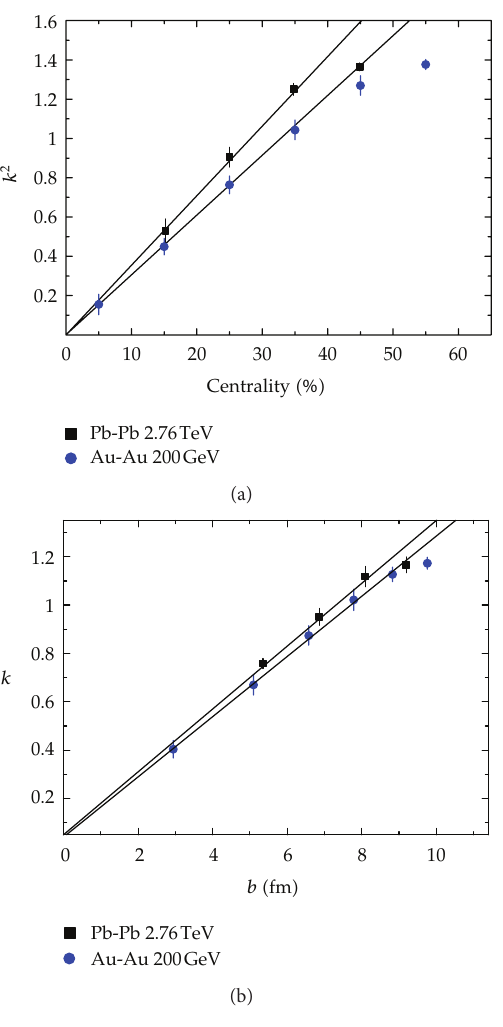
Figure2:Thedependenceoftheexpansionfactor 𝑘 onthecentrality and the impactor parameter 𝑏 . The symbols represent the parameter values used in Figure 1. The lines are fitted